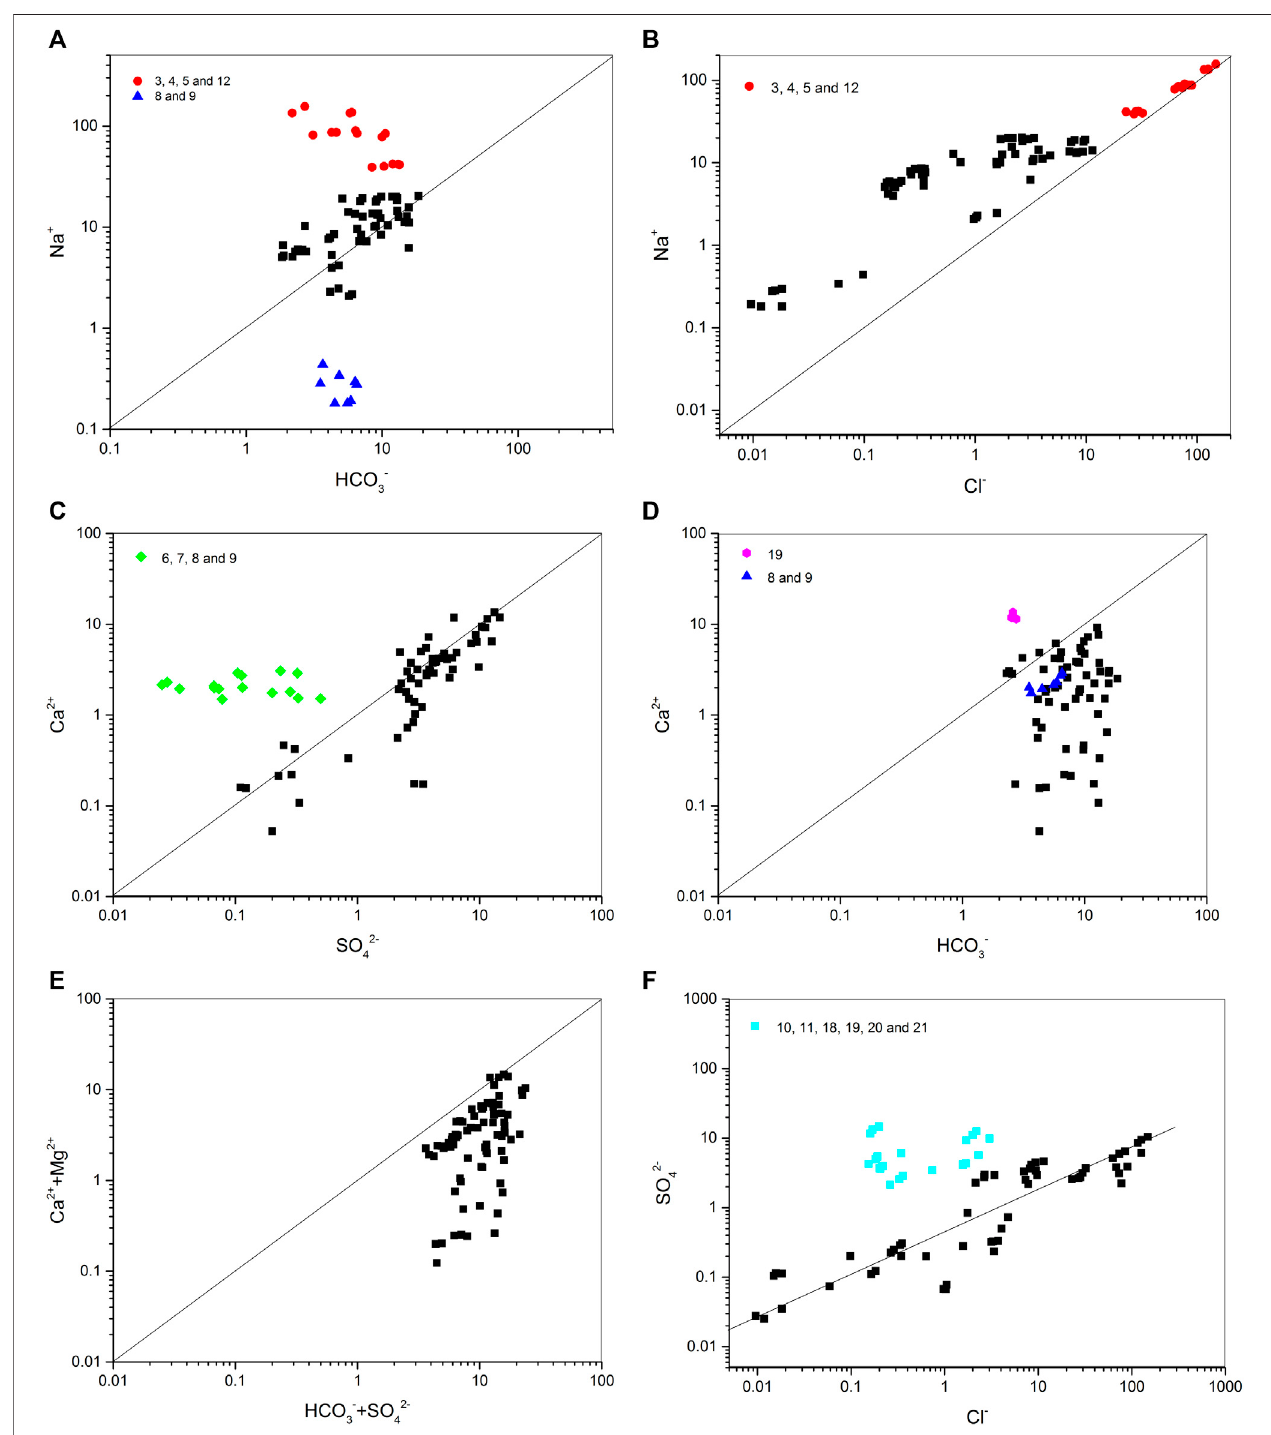
FIGURE3| RelationshipplotsofmajorionsofthespringwaterintheSimaoBasin. (A) HCO 3 − vs.Na + ; (B) Na + vs.Cl − ; (C) SO 42 − vs.Ca 2+ ; (D) HCO 32 − vs.Ca 2+ ; (E) Ca 2+ + Mg 2+ vs. HCO 3 − + SO 4 2 − ; (F) SO 4 2 − vs. Cl − .